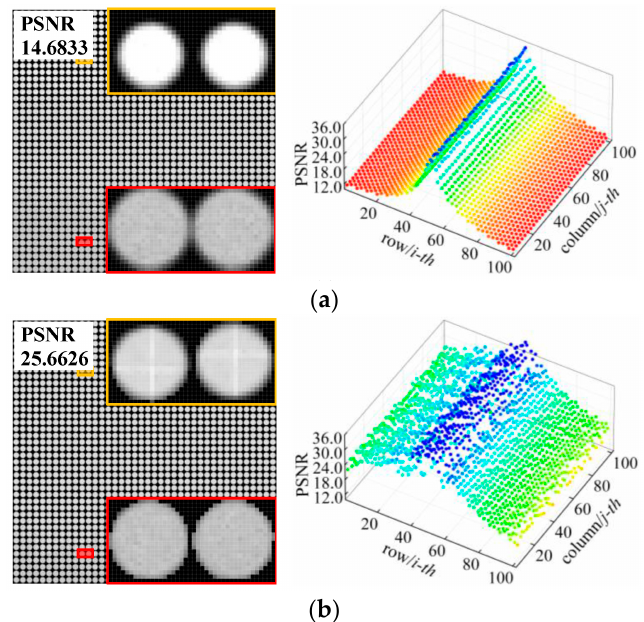
Figure 7. Correction results and deviation distributions for images with tilt error: ( a ) Distorted white raw image with an error of θ = 1.0° and ( b ) its corresponding corrected image. The PSNR values of each case are displayed in the upper left corner of the image.